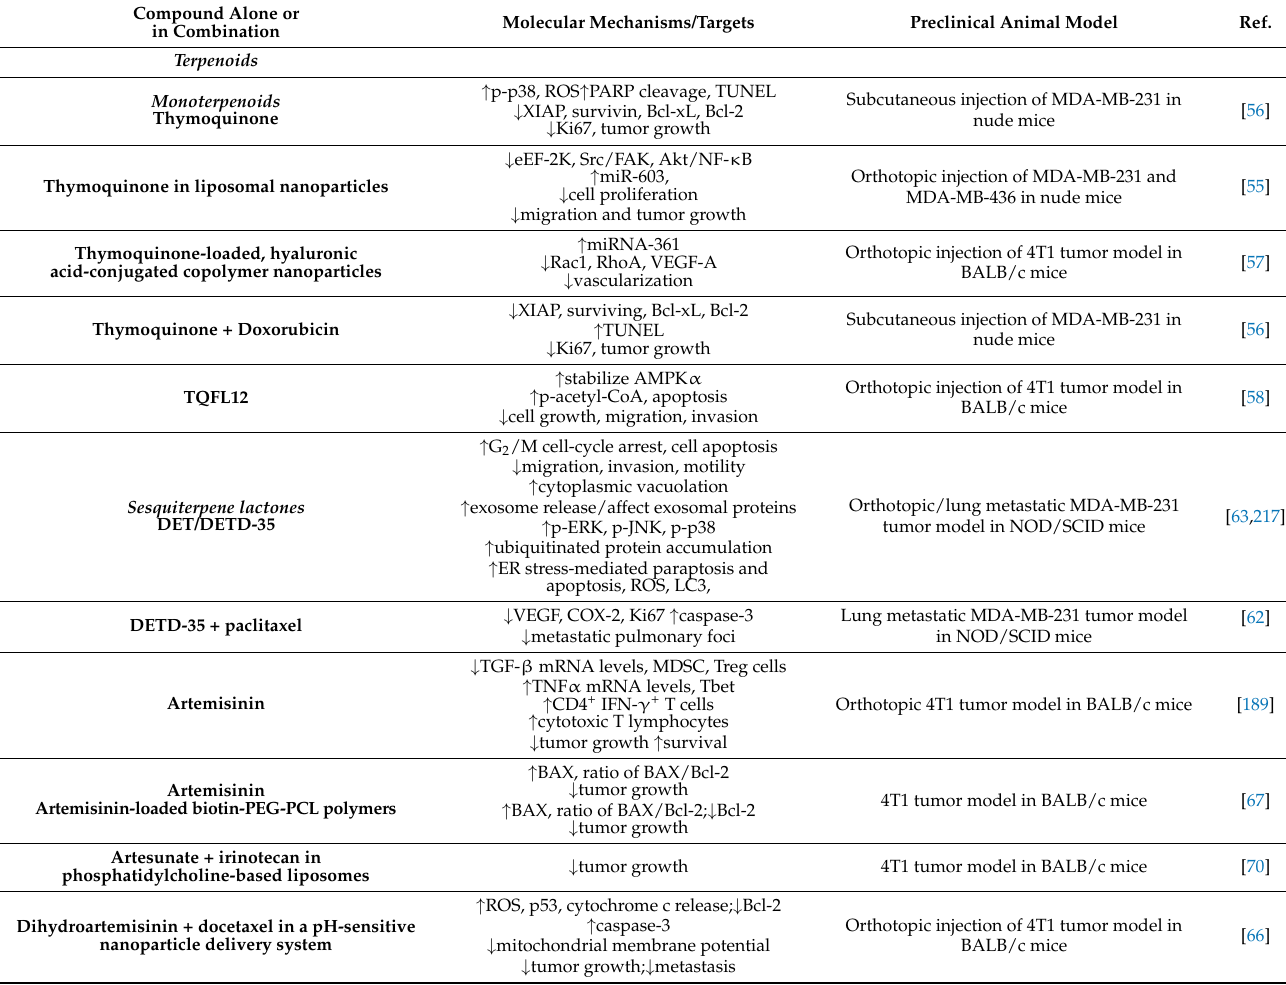
Table 1. In vitro bioactivities, molecular mechanisms, and preclinical animal studies concerning the anticancer effect of bioactive